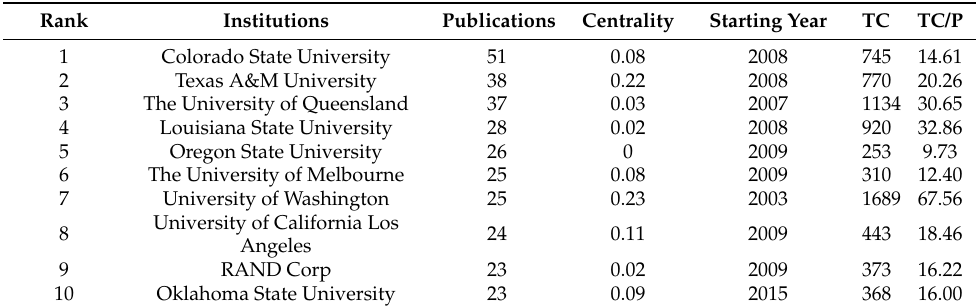
Table 2. Top 10 productive institutions according to publications.